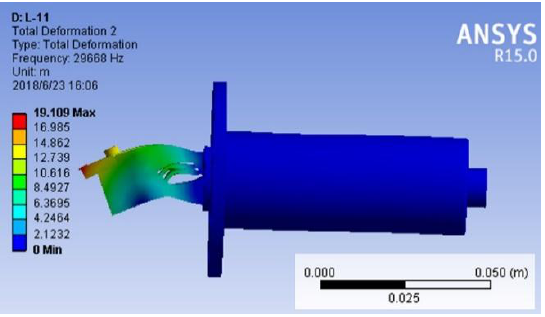
Figure 5. Vibration mode of the designed single driven ultrasonic elliptical vibration cutting ( SDUEVC) device.